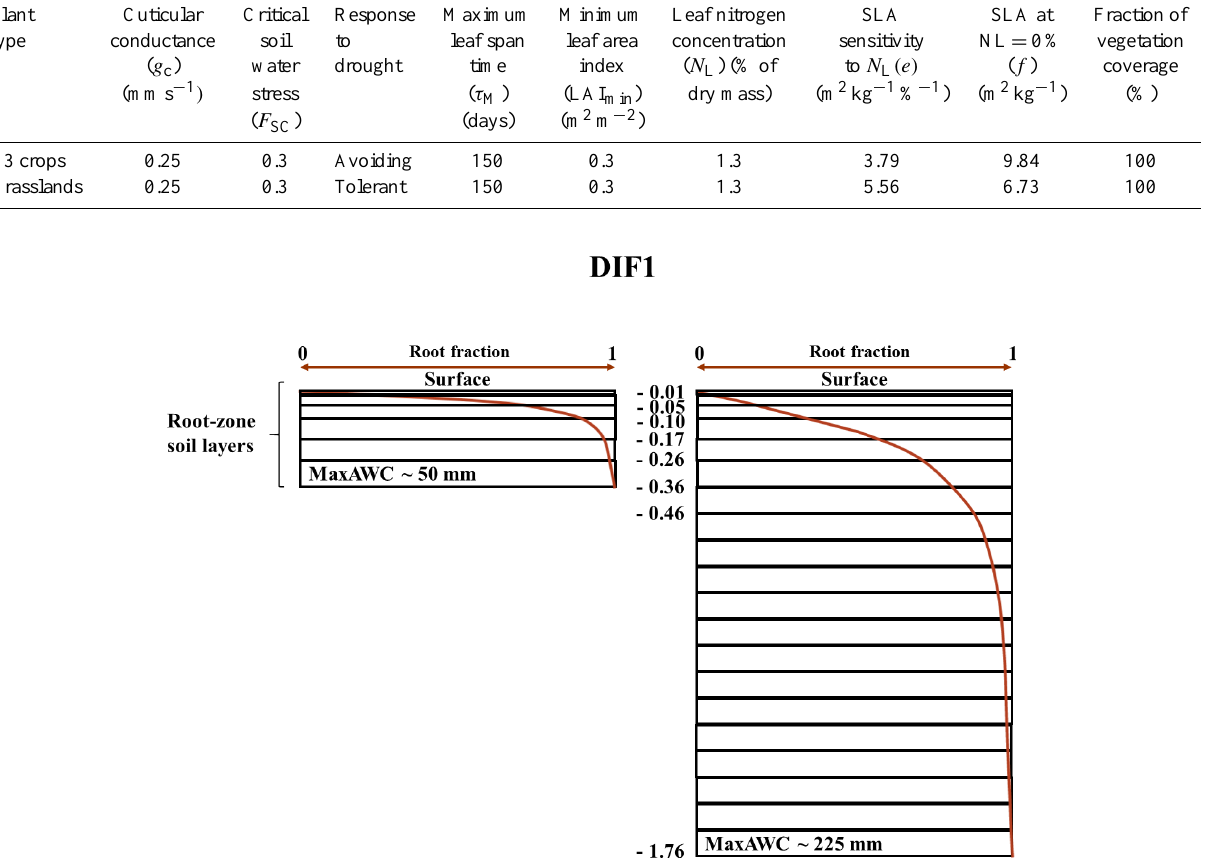
Figure 4. Soil profile of the DIF1 experiment. The soil depth within the root zone is in metres. Only two configurations are represented: for the minimum (left panel) and maximum (right panel) values of MaxAWC (50 and 225mm, respectively). The cumulative root density profile for crops (Eq. 1 with R e = 0.961) is represented by a brown line. A top soil layer of 1cm is